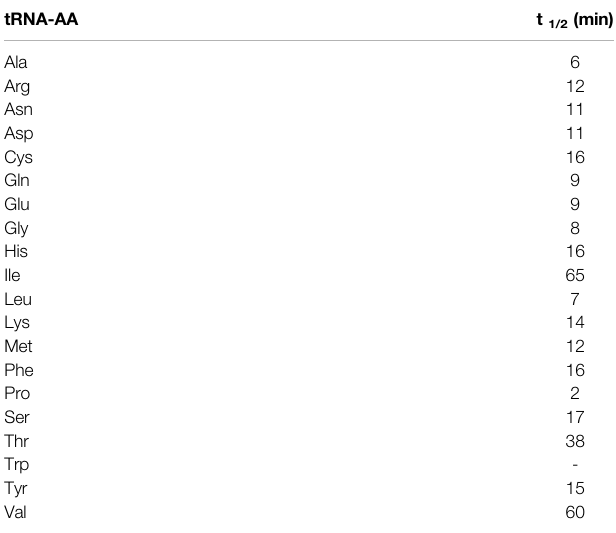
TABLE3| Half-lifevaluesoftRNA-AAfrom E.coli .Valuesobtainedbasedonester bond hydrolysis under neutral or alkaline pH in a high ionic medium at 37 ° C (Hentzen, Mandel, and Garel,